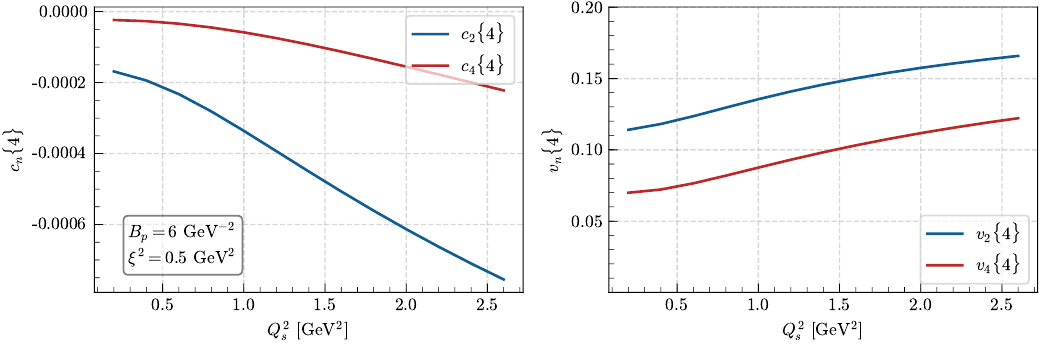
Figure 1: Dependence of the 4-particle cumulant (left) and azimuthal harmonic (right) of second and fourth order with Q 2 s